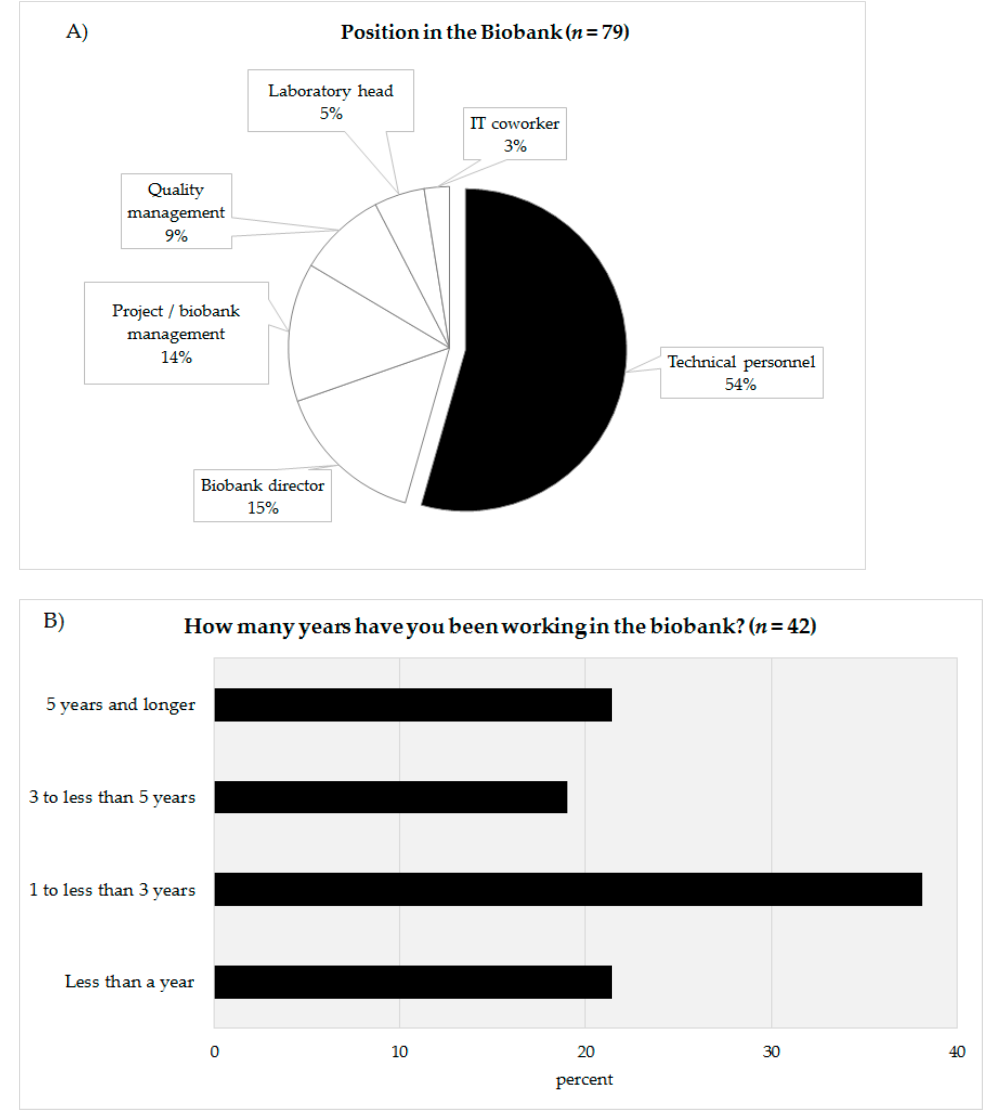
Figure 2. ( A ) Categorization of the survey participants according to their position in the biobank. ( B ) Work experience in years of technical personnel in biobanks .